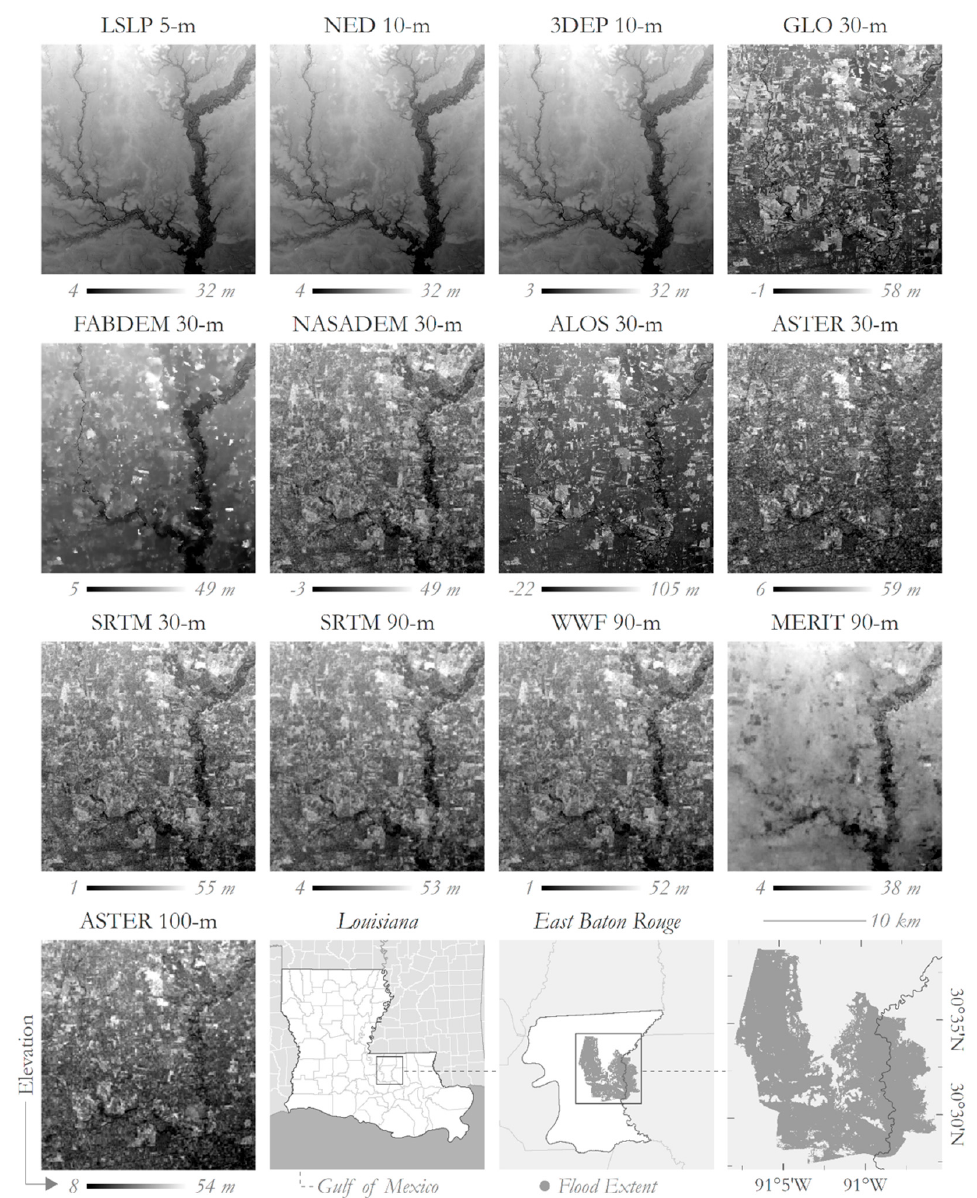
Figure 3. Maps of the 16 DEMs used in the sensitivity analysis. The modeled flood extent is near the city of Baton Rouge along the Amite and Comite Rivers in Central Louisiana. The bottom right panels are the flood footprint and map extent.